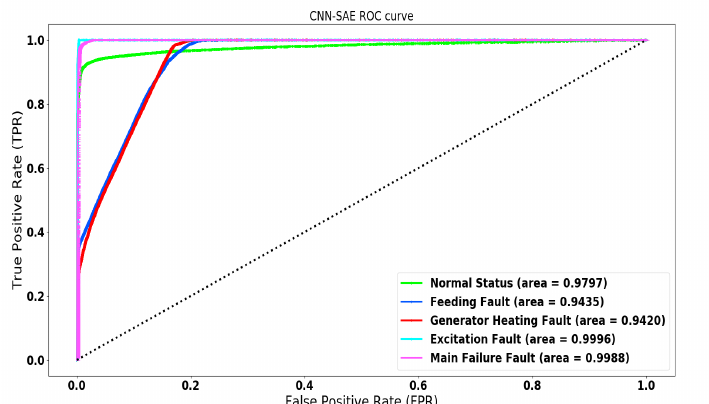
Figure 9. AUC-ROC Curve of Multiclass CNN-SAE Architecture: In this figure we illustrate the AUC-ROC Curves for the five fault detection of the wind turbine dataset. In further detail, the proposed CNN-LSTM architecture achieves: 97.9% for the Normal State, 94.3% for the Feeding Fault, 94.20% for the Generator Heating Fault, 99.9% for the Excitation Fault, and finally 99.8% for the Main Failure